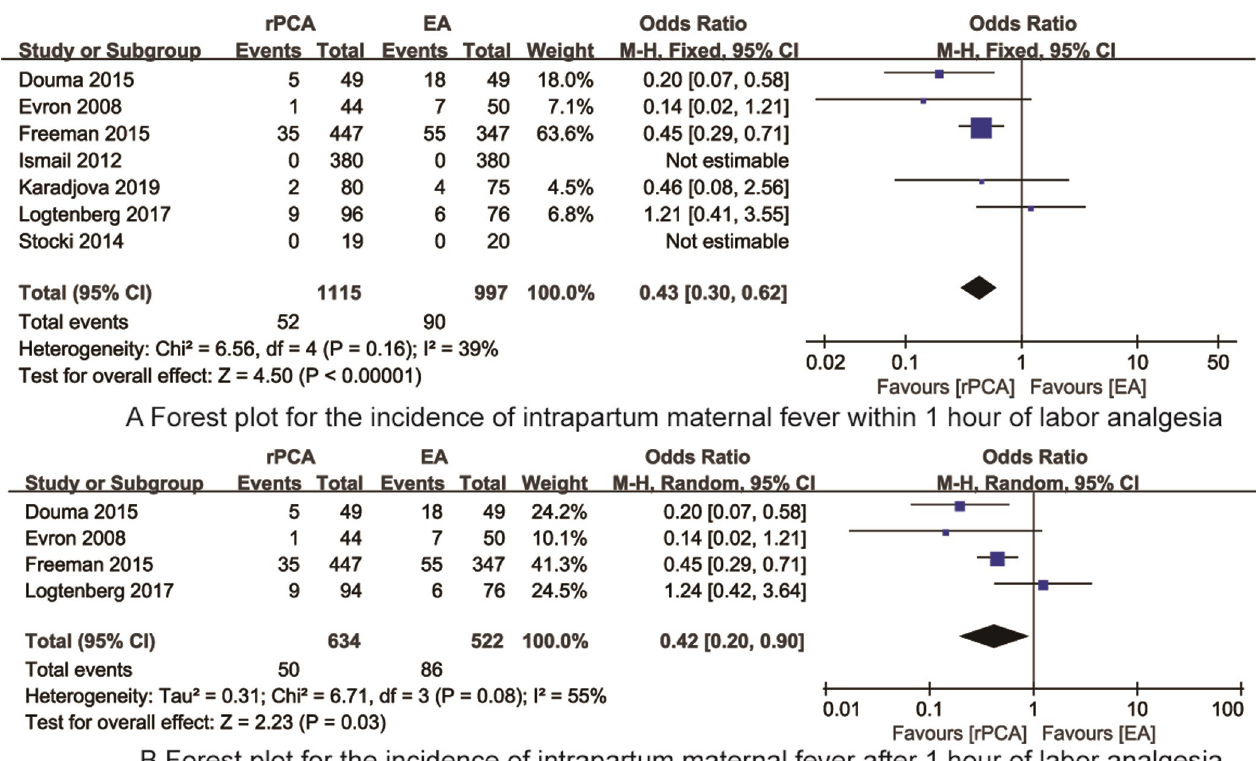
Fig 4. The forest plot for the incidence of intrapartum maternal fever.